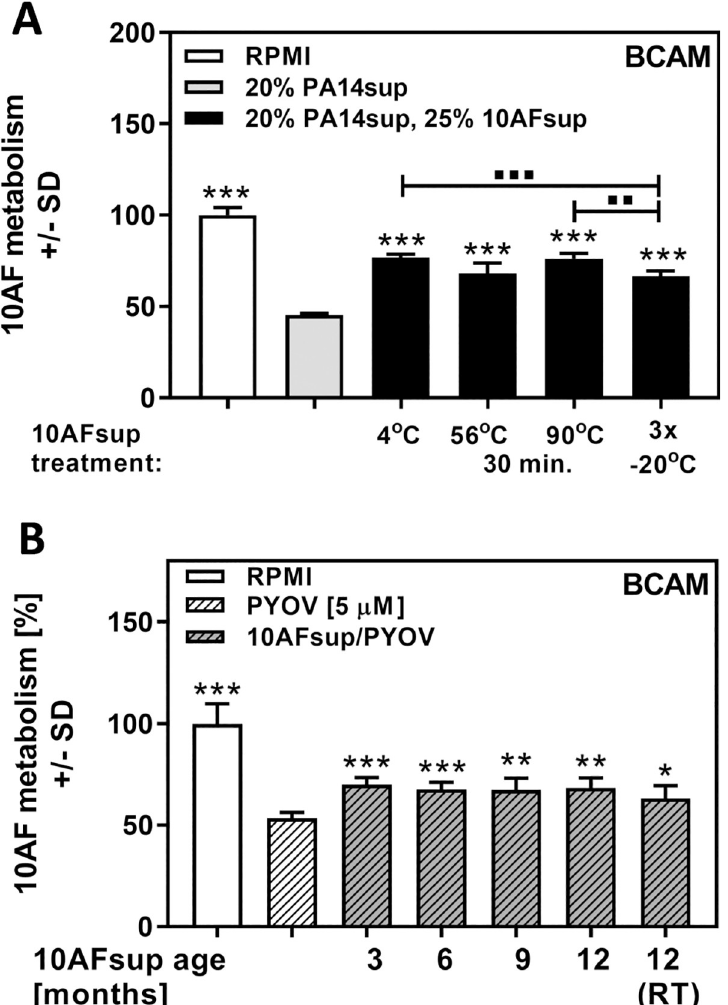
Fig 2. Stability of Afsup. A: Mixtures (25%) of freshly prepared 10AFsup in RPMI were kept at 4˚C, or heated to 56˚C or 90˚C for 30 minutes, or subjected to 3 freeze-thaw cycles. Treated 10AFsups (25% in RPMI), were combined with 20% P . aeruginosa supernatants, and tested for effects on A . fumigatus forming biofilm metabolism. B: 10AFsup was stored at 4˚C for up to 12 months, and tested for protective activity against 5 μ M pyoverdine (PYOV) every 3 months. A portion of the 10AFsup was stored at room temperature (RT), and tested after 12 months of storage. Protective activity was tested using a BCAM assay. Statistics for A: t-Test, PA14 supernatant (grey bar) vs. all other bars. Other comparisons as indicated by the ends of the brackets. � indicate significant increases, ■ indicate significant decreases. Statistics for B: t-Test, pyoverdine (white striped bar) vs. all other bars. One, two or three asterisks or squares = p � 0.05, p � 0.01 or p � 0.001,